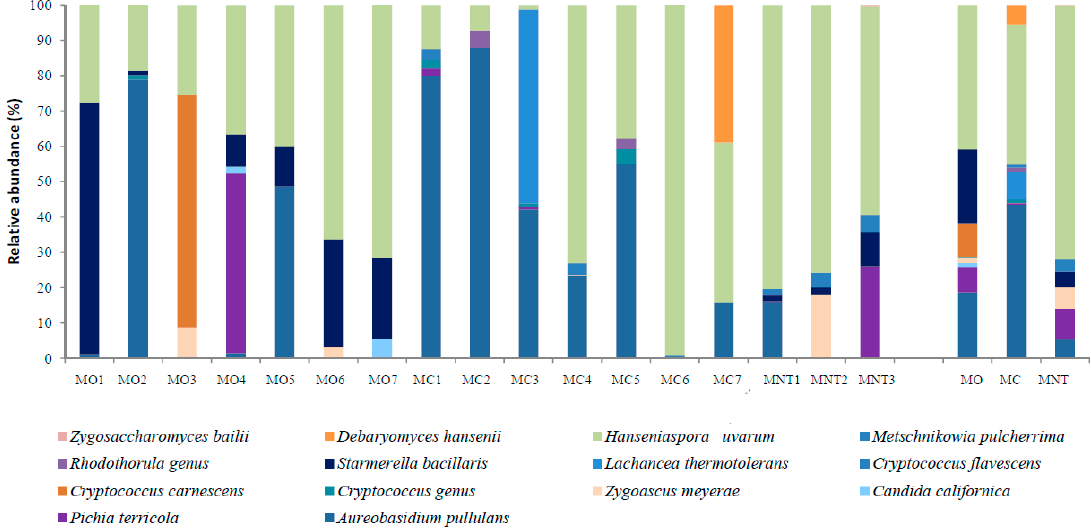
Figure 3. Relative abundance of the grape yeast community detected by the culture-dependent method at harvest time in organic (MO), conventional (MC) and not treated (MNT) samples. The number associated to the samples represent the replicates for each treatment. To the right of the graph, mean values of each treatment are represented (MO, MC and MNT).